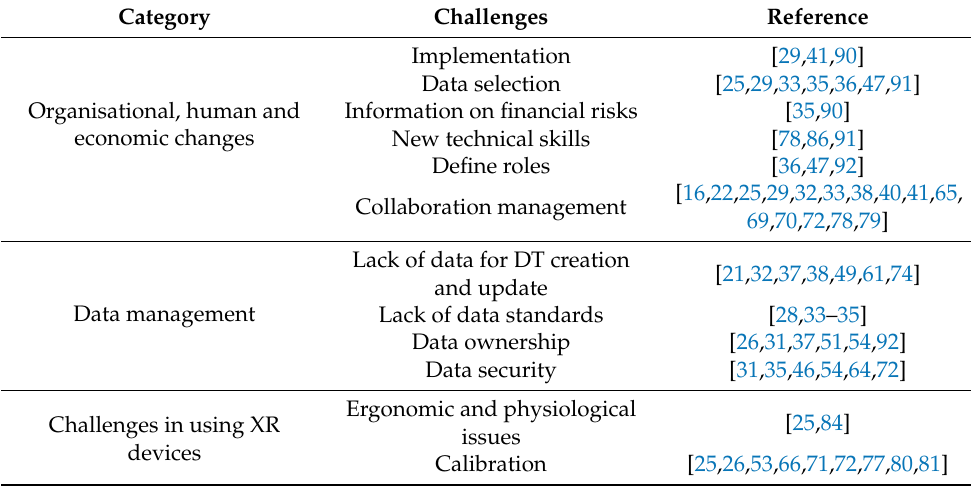
Table 9. Categorical review of the new needs for correct